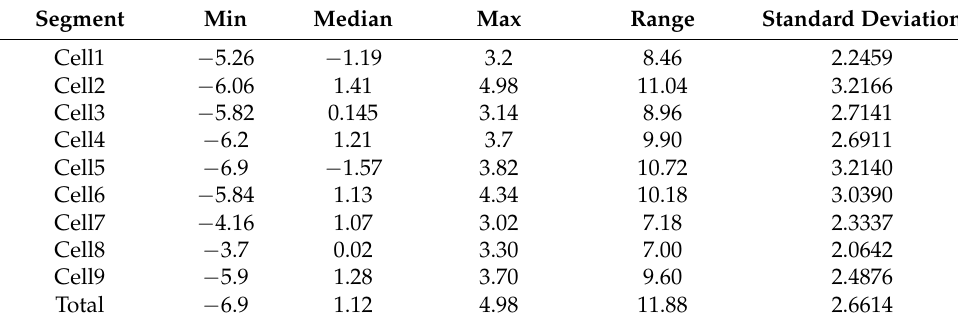
Table 12. Time speed difference statistics under cooperative control.